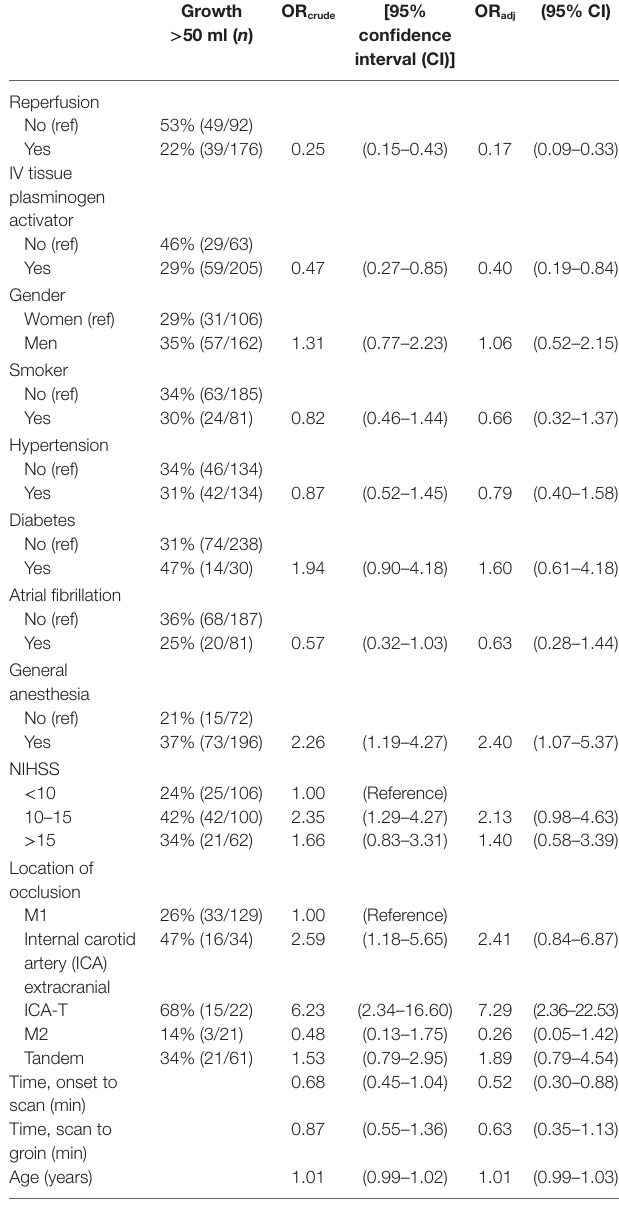
Table 3 | Predictors for infarct growth above 50 ml, n = 268.